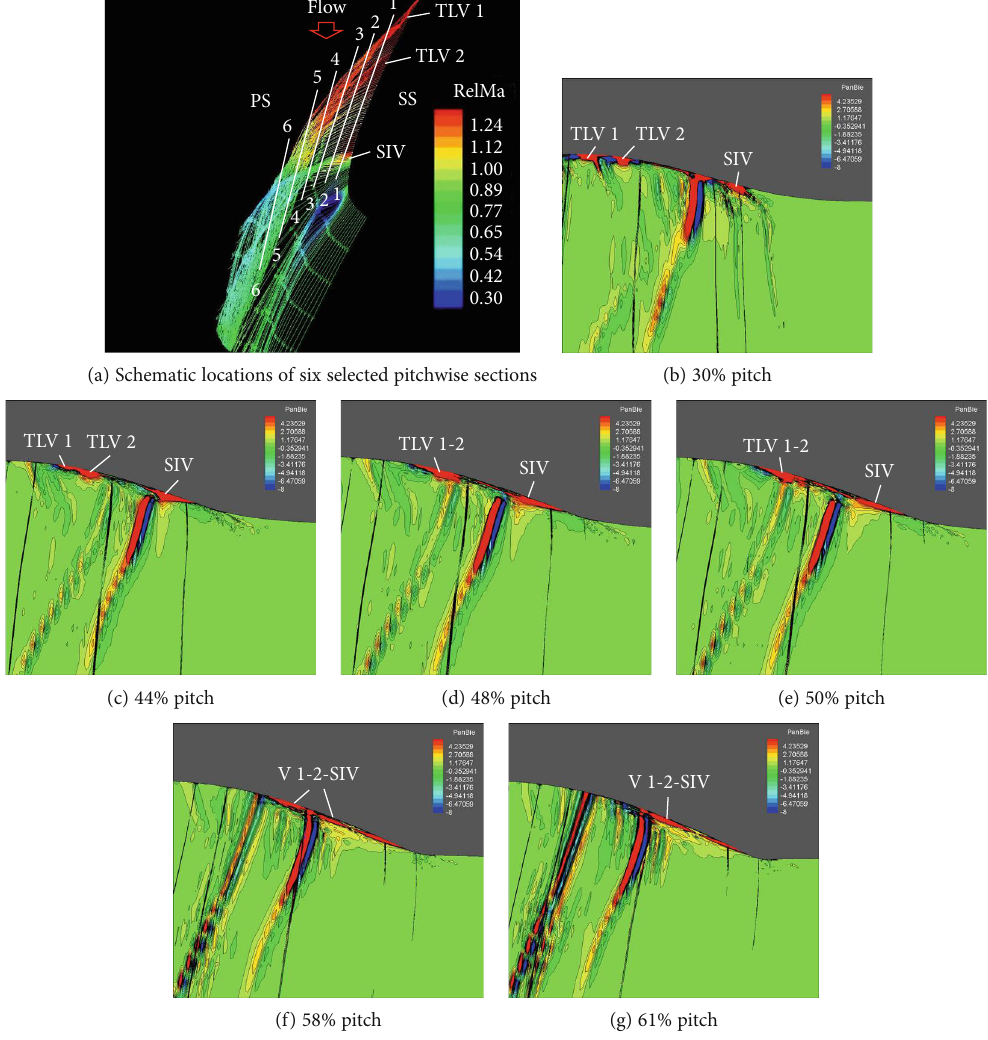
Figure 22: Identi fi cation of vortex existence in the tip region by parameter PanBie at near-peak e ffi ciency